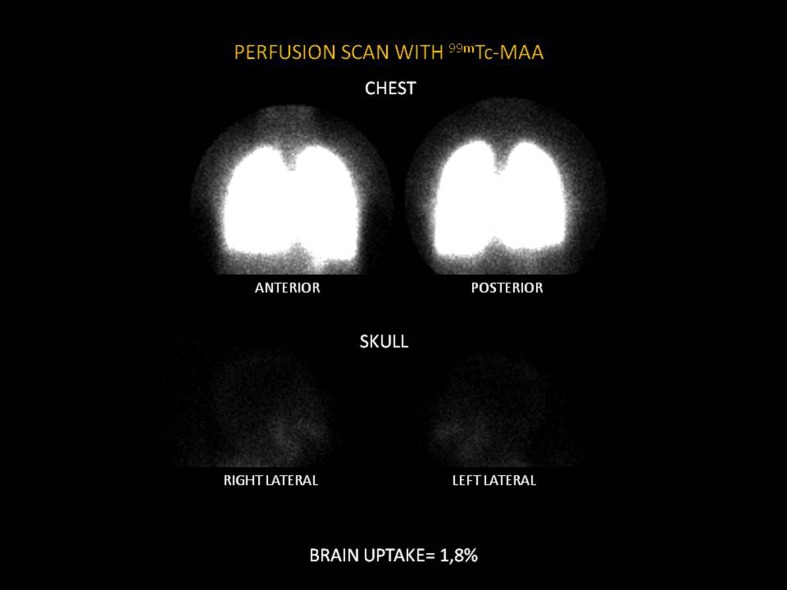
Normal scintigraphy.Brain uptake = 1.8%.